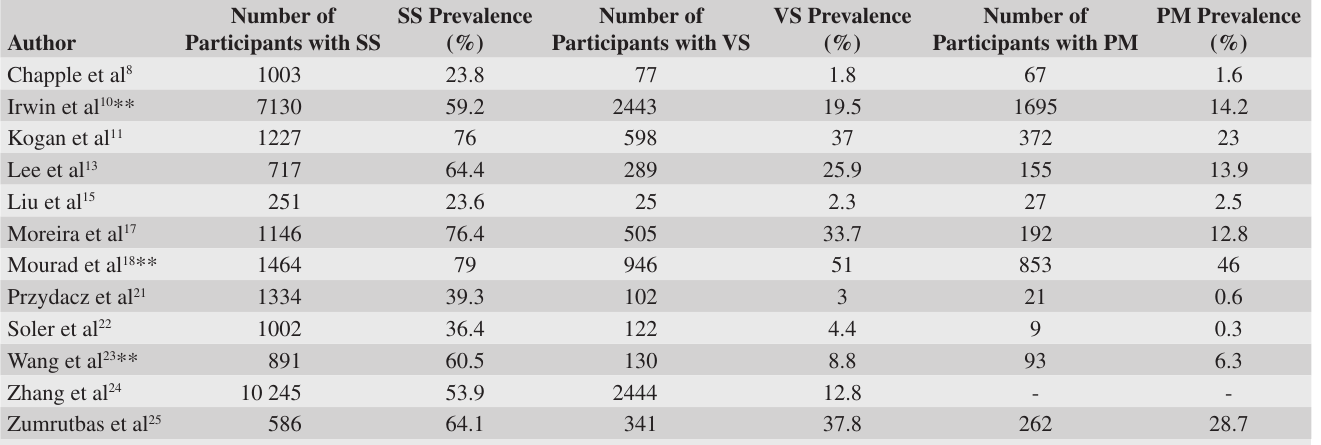
Table 3. The Prevalence of Voiding and Storage Symptoms